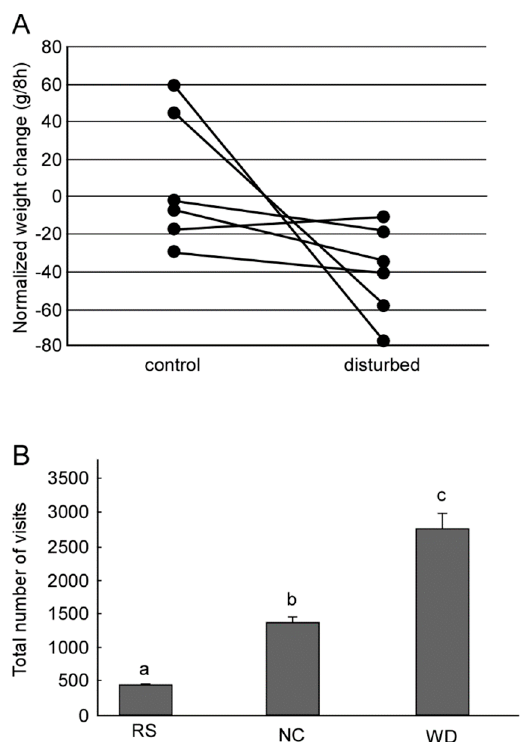
Figure 2. Availability of dance for food collection. ( A ) The daily weight changes. Six colonies were examined. One colony measured its weight in both dance-preventing (disturbed) and non-preventing (control) conditions. Dots connected by each line represent each colony. ( B ) Total number of visits to feeders of three virtual colonies in terms of visits to feeders. Foraging characteristics is different among the virtual colonies. Bees in random-search colony (RS) make foraging without locational memory of food sources or dance communication. Bees in no-communication colony (NC) memorize the location of the food source if they found and use it for later foraging, but make no dance communication. Bees in a waggle dance colony (WD) memorize the location of the food source and use it, and perform waggle dance to transfer locational information. The letters above the boxes represent groups showing statistically significant differences (ANOVA and post-hoc Tukey–Kramer test). (A,B were modified from [8,18], respectively).